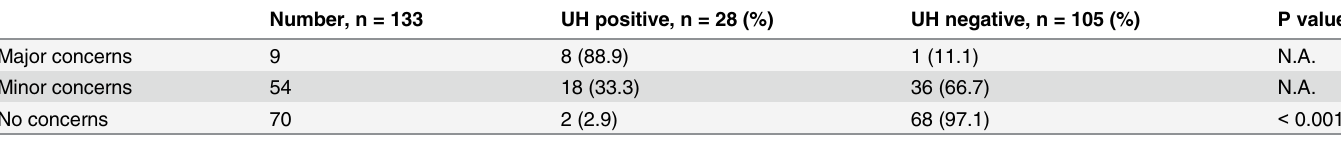
Table 5. The correlation between concerns and unintended hospitalization.